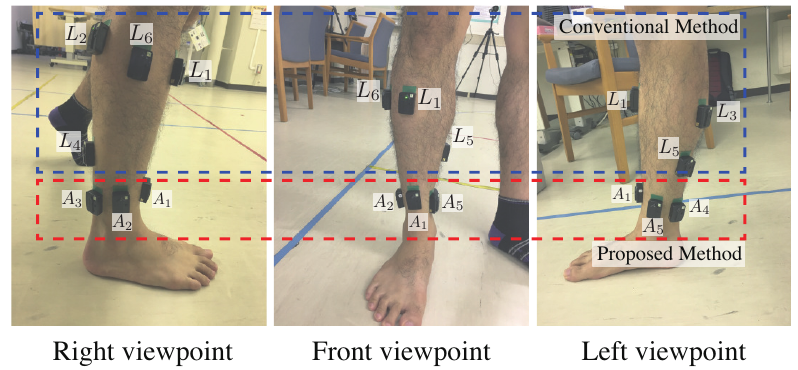
Figure 2. Sensors positions for the right lower leg. A 1 - A 5 are the proposed positions. EMG signals from targeted muscles are obtained from L 1 - L 6 . Table 1. Relationships between sensor labels and muscles.